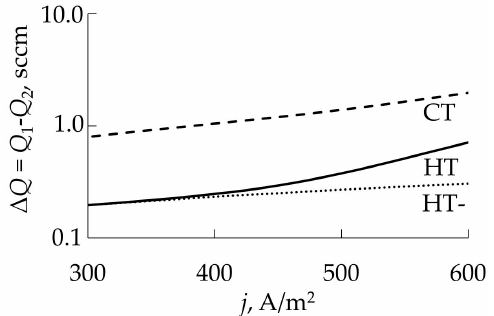
Figure 23. Dependences of the hysteresis width on the current density during sputtering: CT—cold target; HT—hot target; HT – —hot target without evaporation.